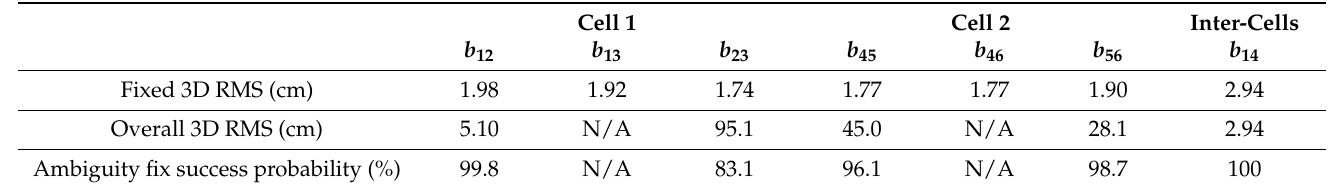
Table 7. The 3D RMS positioning errors of the baselines in the two cells and two master agents using a one-to-one and antenna-array RTK of the proposed framework with the satellite configuration in Figure 19.